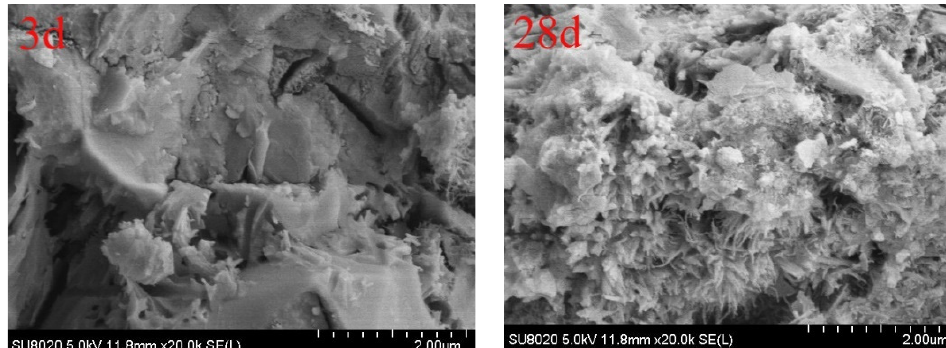
Figure 10. Results of the PM1 sample SEM for different ages.